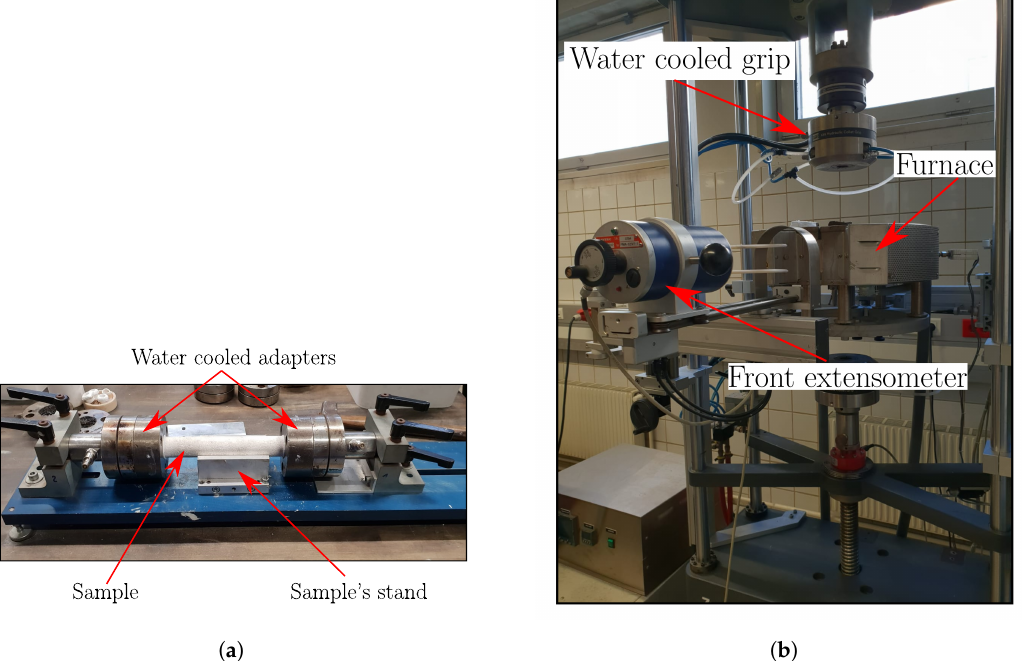
Figure 2. Tensile creep experimental setup. ( a ) Gluing device. ( b ) Testing